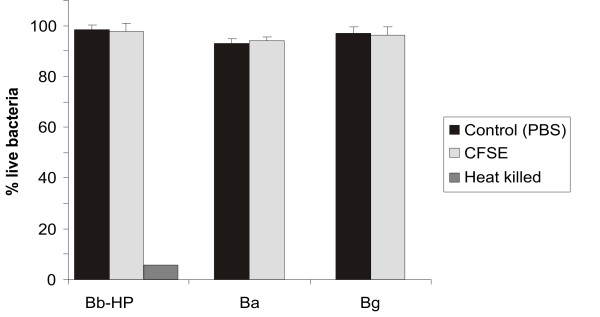
Viability of Bb-HP, Ba and Bg after staining with CFSE. Borreliae treated according to the staining protocol, with the exception of using PBS instead of CFSE, served as negative control. After the staining procedure, 3.2 μM propidium iodide (PI), staining the DNA of dead bacteria red, was added. Heat-killed and PI stained Bb-HP of a representative experiment are also shown to demonstrate the proper functioning of the PI-staining. The percent of PI-negative bacteria was determined by flow cytometry. Values are expressed as mean ± standard deviation from three to four different experiments. p ≥ 0.1 was obtained for each CFSE labelled strain versus corresponding control.